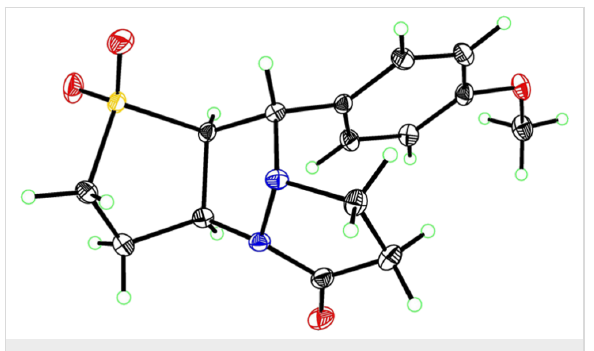
Figure 1: X-ray structure of 3a .